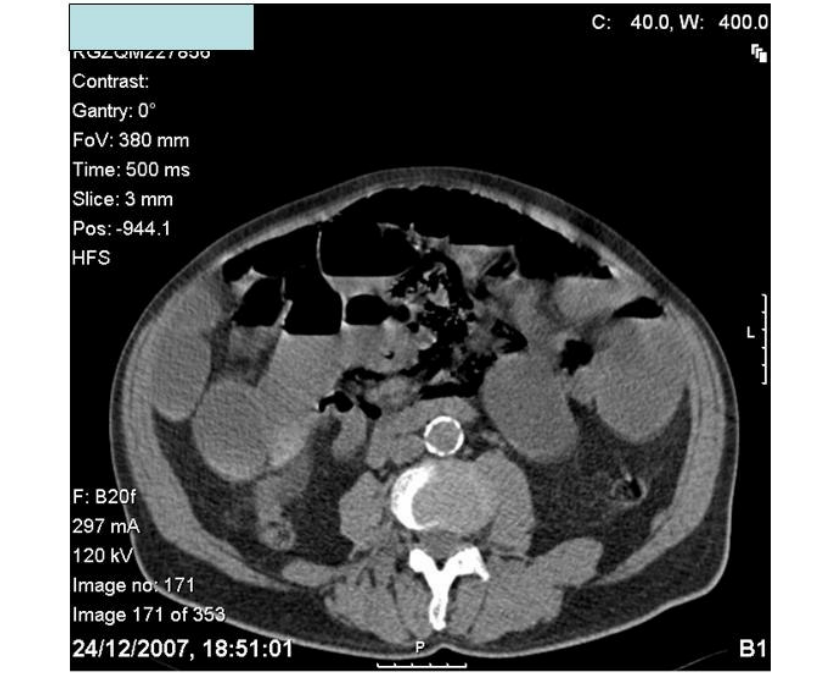
FIGURE 5. CT scan of the abdomen showing air fluid level in the small